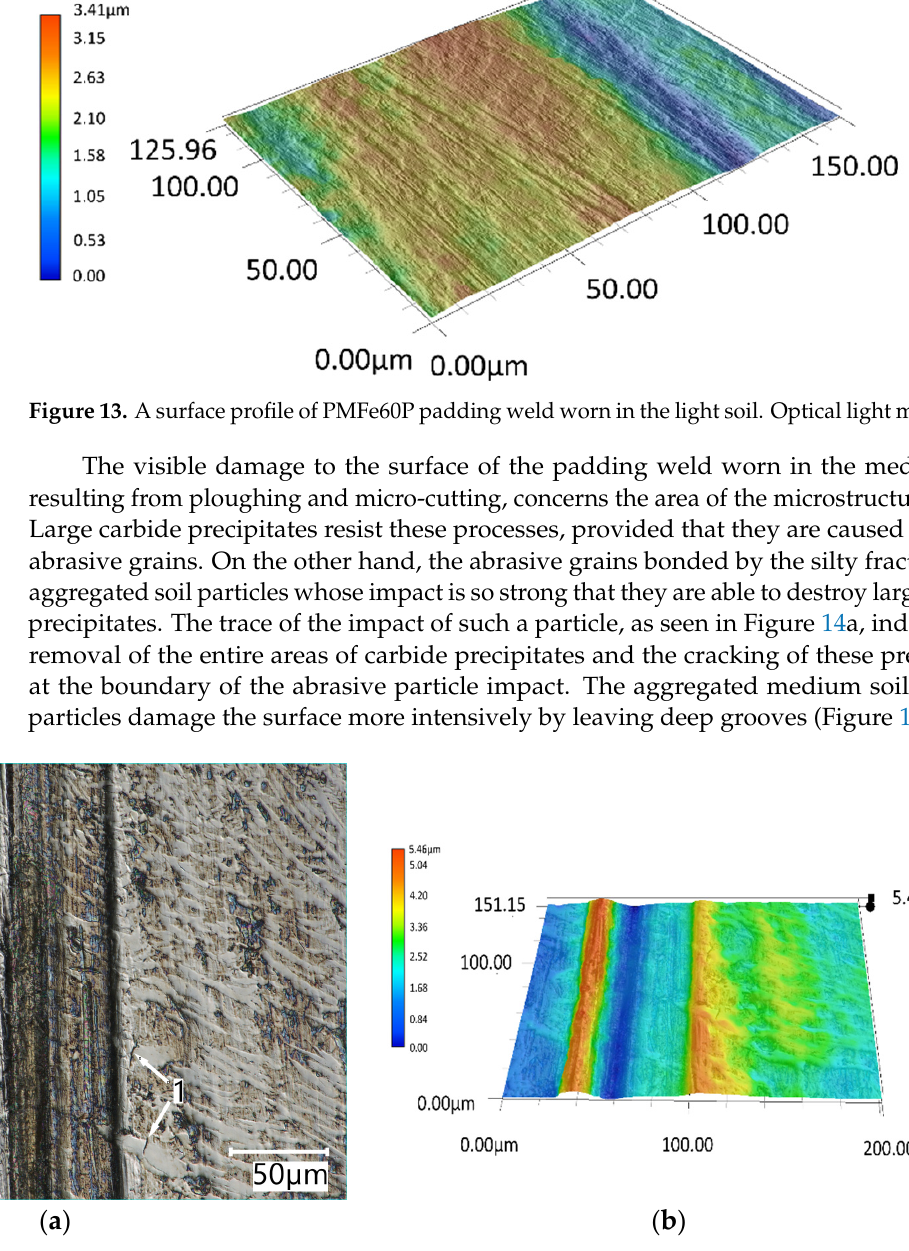
( d ) Figure 15. The surface of Vanadis 60 SuperClean (O) and Vanadis SuperClean (W) worn in the medium soil ( a ), ( c ) and light soil ( b ), ( d ): 1—ploughing, 2—chipping. Optical light microscopy.